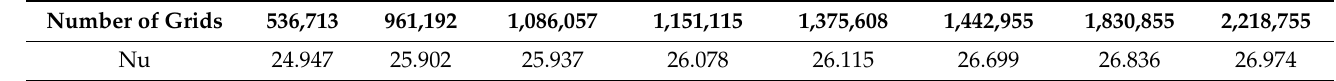
Figure 6. Created meshes for the computational domain of shell and tube heat exchanger. Table 5. Mesh independence study.